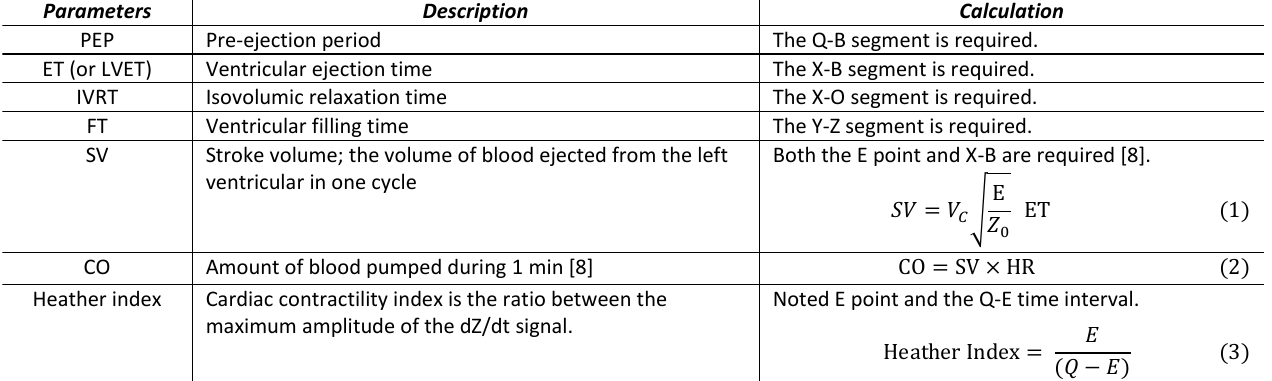
Table 2. Hemodynamic parameters calculated using ICG characteristic